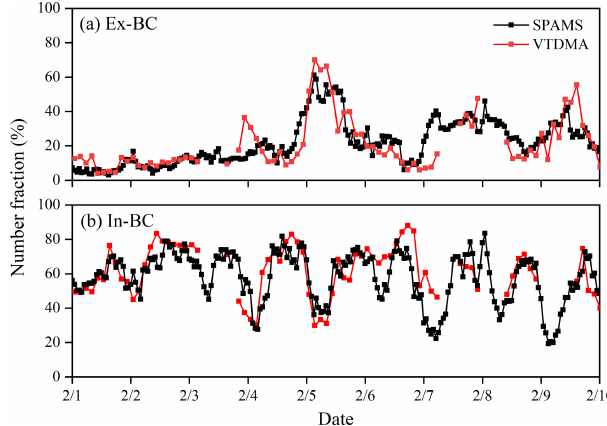
Figure 4. Time series of number fraction of (a) Ex-BC particles and (b) In-BC particles measured by SPAMS (in black) and calcu- lated from VTDMA (in red); the 200nm particles from VTDMA and SPAMS are chosen for comparison (1–10 February